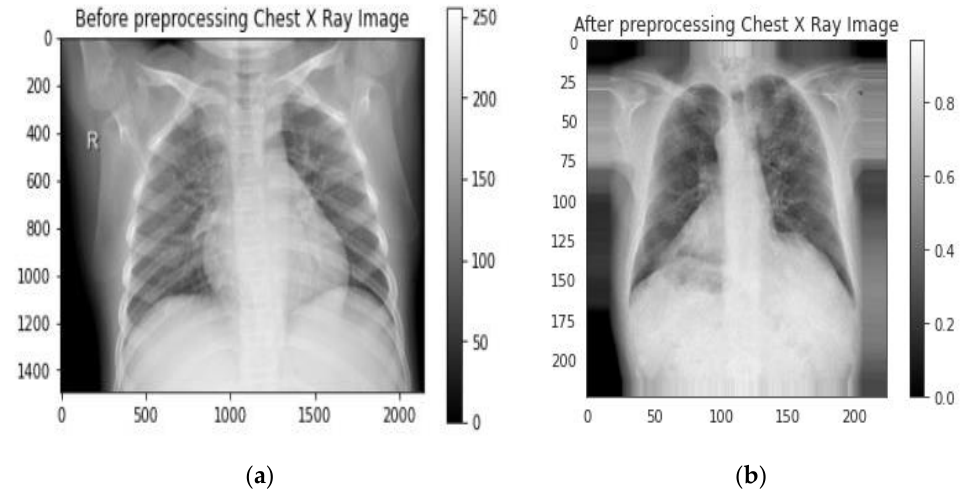
Figure 4. X-ray image before preprocessing: ( a ) picture; ( b ) X-ray image after preprocessing.